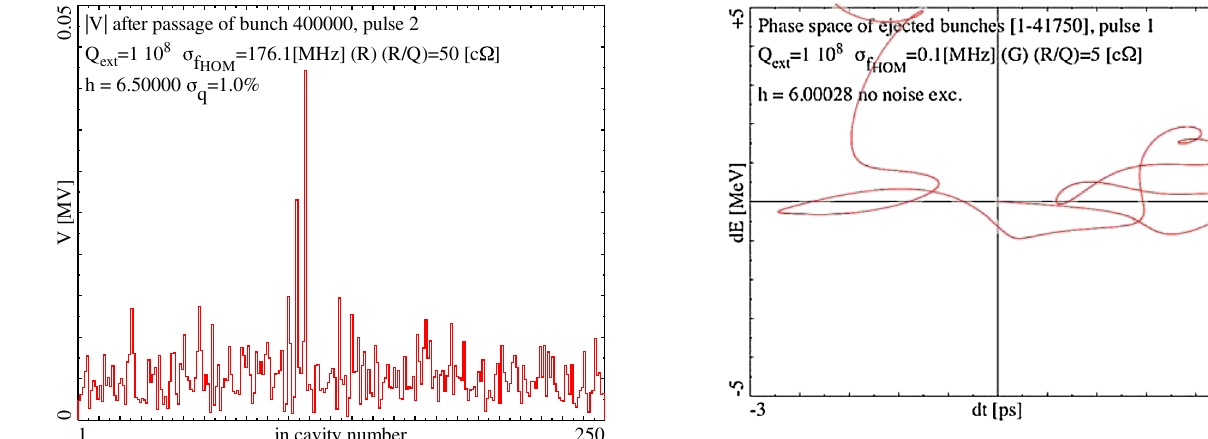
FIG. 38. (Color) Phase-space image of the ejected bunches of the second pulse. Conditions as Fig. 8 with Q ext ¼ 10 8 but h f H i 100 kHz away from a machine line, ð R=Q Þ ¼ 5 (cid:2) . The pulse was aborted after about 40 000 bunches.